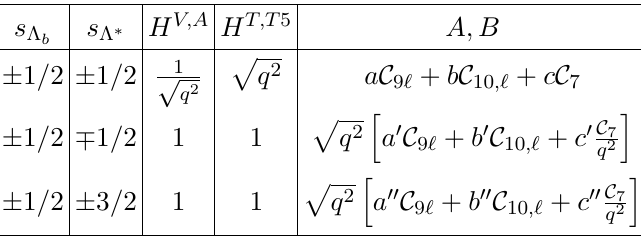
Table 2 . Behaviour of the amplitudes for (cid:3) b ! (cid:3) (cid:3) ( ! N (cid:22) K ) ‘ + ‘ (cid:0) in the q 2 ! 0 limit in the SM. a; b are generic numbers coming from the kinematics and the form